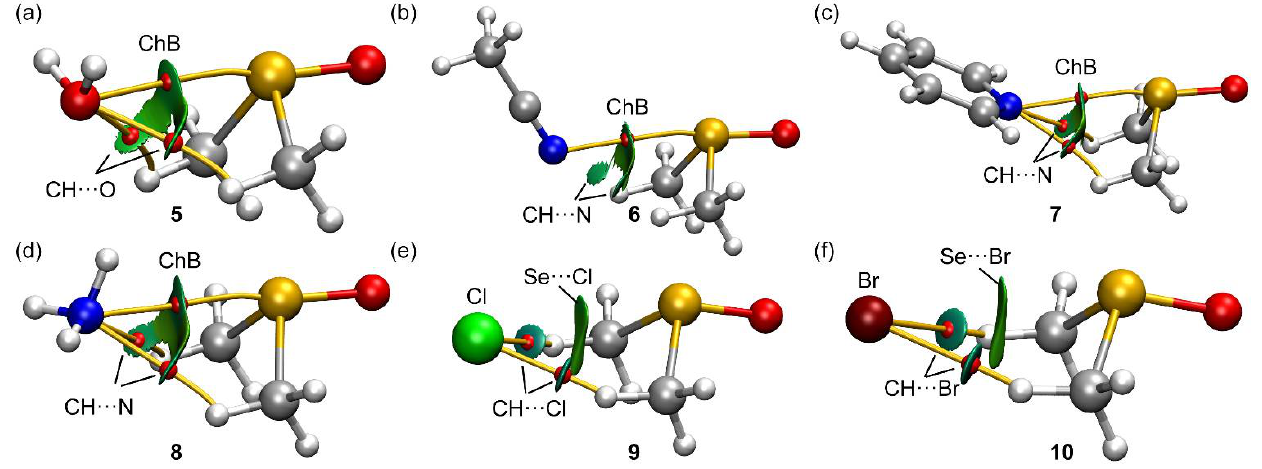
Figure 6. Combined QTAIM (bond critical points as red spheres and bond paths as yellow lines) and NCIPlot analyses of complexes 5 ( a ), 6 ( b ), 7 ( c ), 8 ( d ), 9 ( e ), and 10 ( f ) at the PBE0-D3/def2-TZVP level of theory. Only intermolecular interactions are represented.